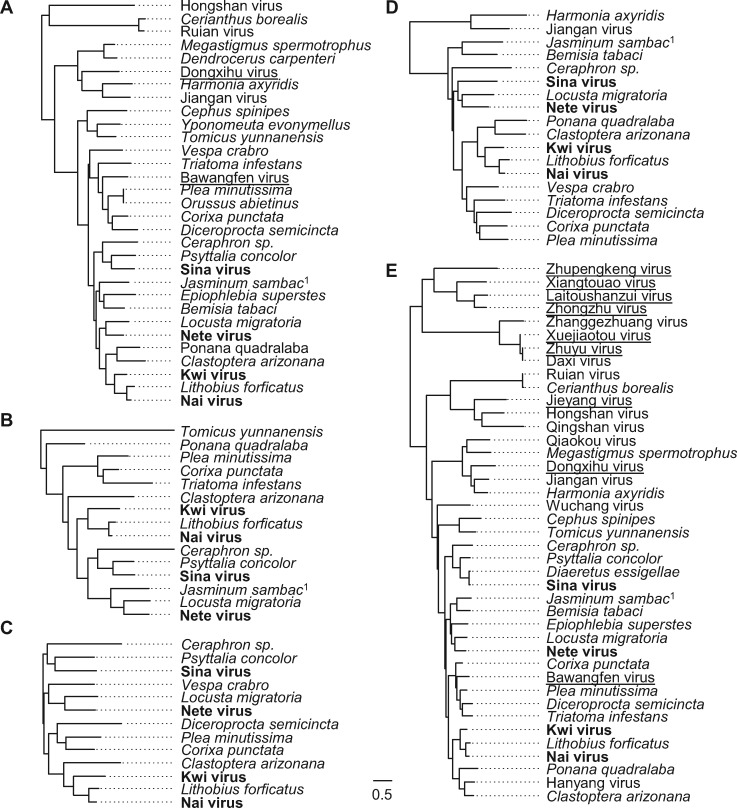
Phylogenetic trees for each of the viral segments. Panels A–E show maximum-likelihood phylogenetic trees for segments 1–5, inferred from amino-acid sequences. Panel E shows the tree for the most conserved segment, which encodes a putative RdRp. Trees are mid-point rooted, and the scale bar represents 0.5 substitutions per site. The four viruses marked in bold are the founding members of the clade, those underlined come from nominally vertebrate metagenomic datasets, and species names in italic denote sequences from public transcriptomes. One, J. sambac (marked superscript 1), came from a plant transcriptome contaminated with the whitefly D. kirkaldyi. Note that some aspects of tree topology appear to be consistent among segments, suggesting that reassortment may be limited. Sequence alignments and tree files are provided via Figshare doi:10.6084/m9.figshare.11341982.